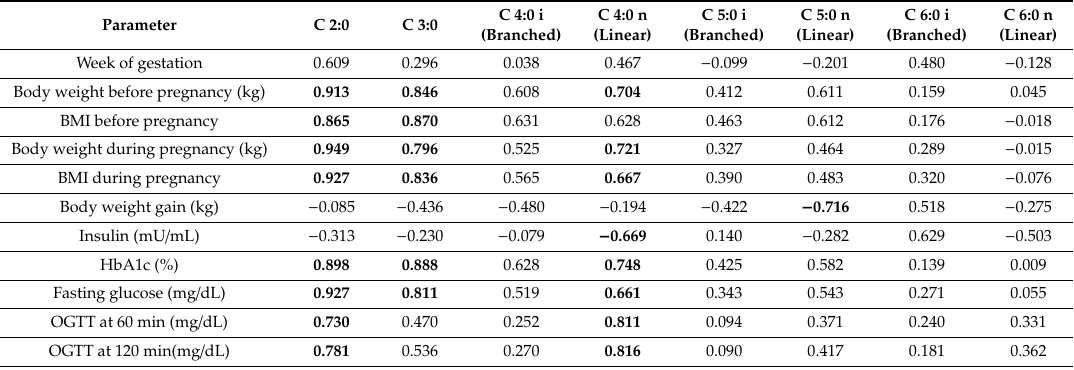
Table 5. Analysis of the relationship between SCFAs in the stool, anthropometric parameters, and the carbohydrate metabolism parameters in the control group